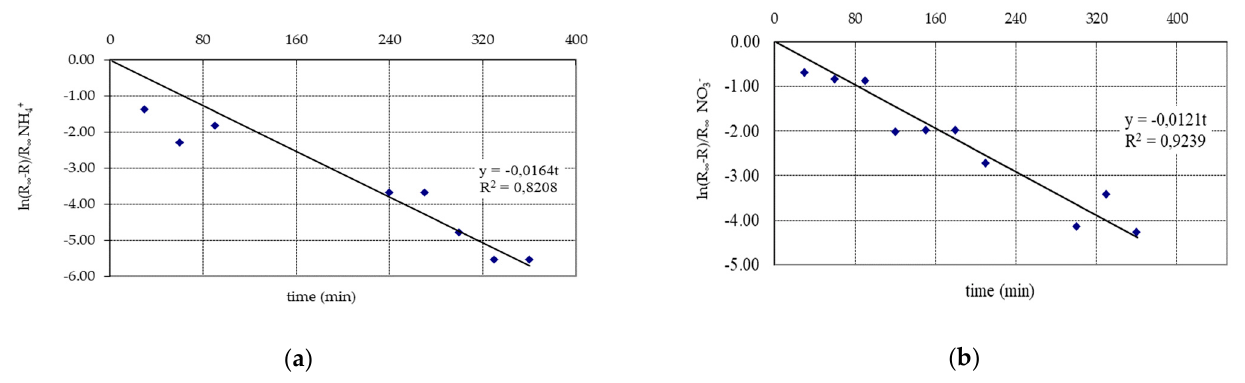
Figure 2. The method of determining the constant t R 0 of the reverse osmosis process: ( a ) NH 4+ enriched infiltration water, ( b ) NO 3- enriched infiltration water. Table 3. R fo resistance values determined from the experiment and theoretical for t RO .